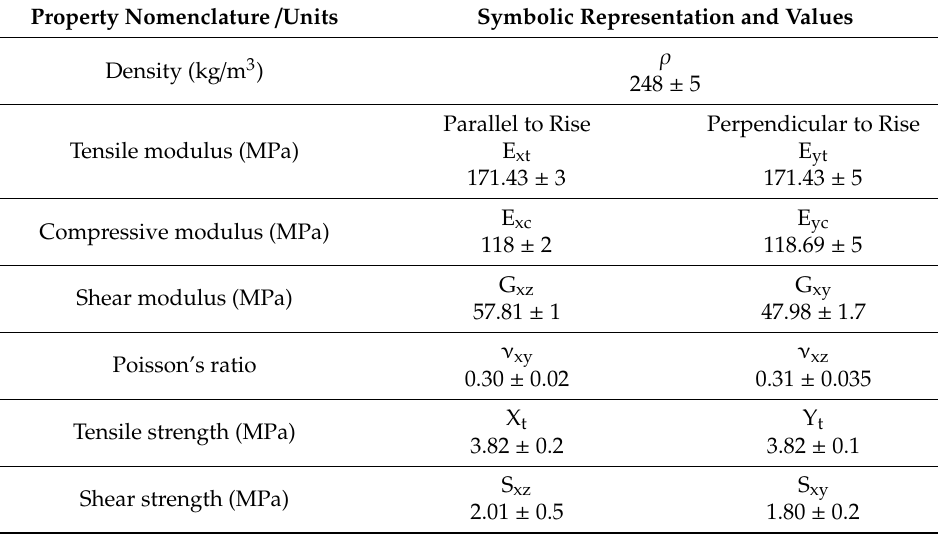
Table 2. Mechanical properties of polyurethane